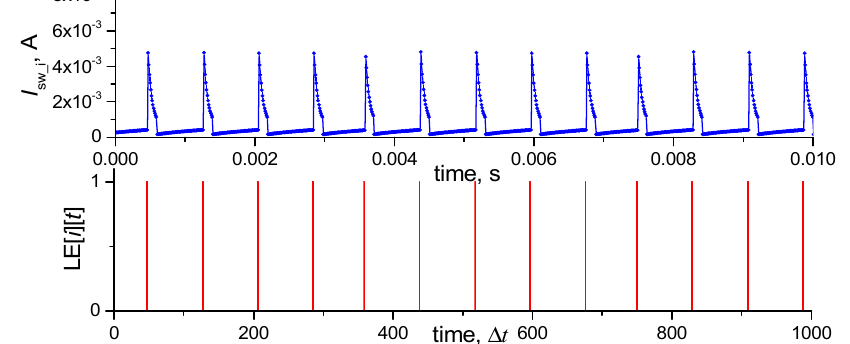
Figure 2. Oscillogram of oscillator current and the corresponding array of positions of the leading edges of the current pulse LE[ i ][ t ]. (where i is the oscillator number, time t = n · ∆ t , n is number of the calculation steps of the model oscillogram, ∆ t is the calculation time interval).